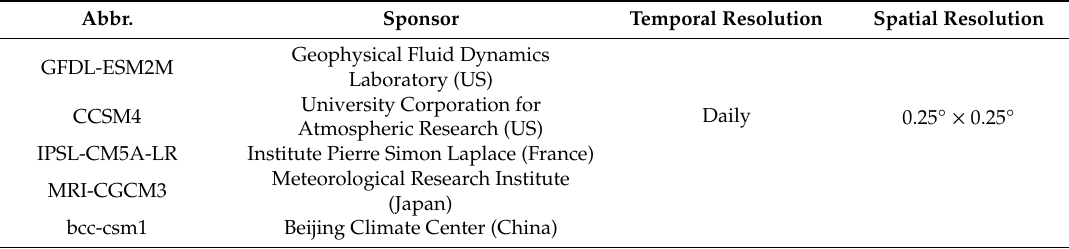
Table 2. Climate change GCMs used in this study.